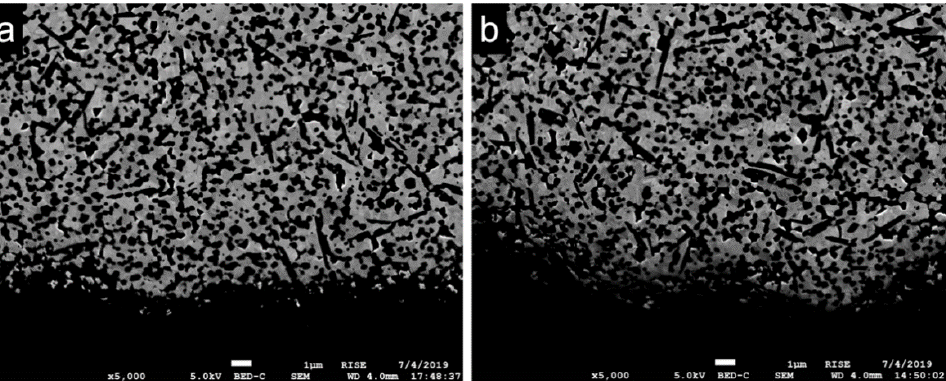
Figure 5. ( a ) SEM image (×5000) depicting the endosseous implant surface without treatment (group A0) and ( b ) after combined dynamical loading and hydrothermal aging (group ALH). No distinct transformation zone was observed after treatment.